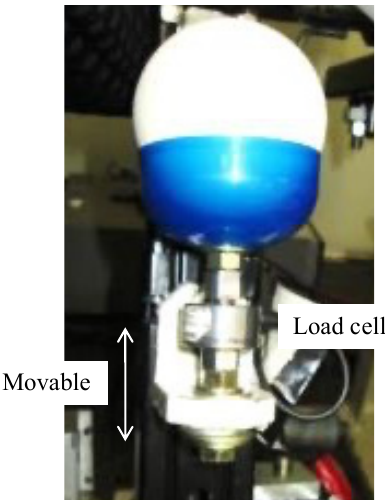
Figure 1. Pushing device for sensory sensitivity.